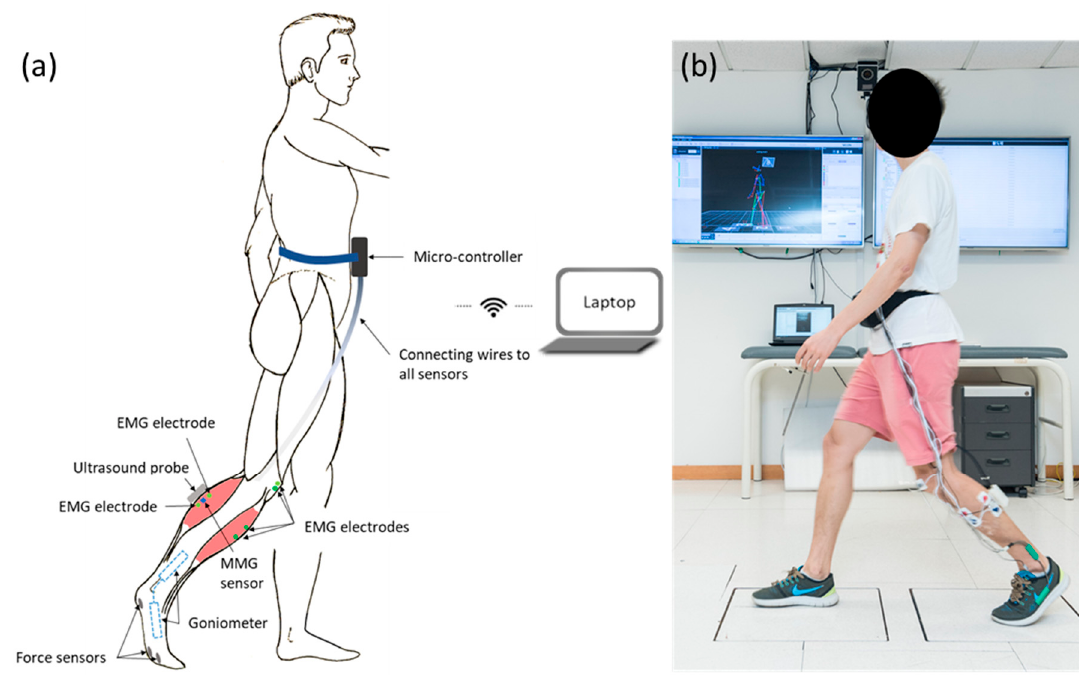
Figure 1. ( a ) An illustration of the wearable mobile sensing system with real-time ultrasound imaging and location of ultrasound probe, electromyography (EMG) electrode, mechanomyography (MMG) electrode, force sensors, and goniometer at shank and foot. ( b ) A demonstration of a subject wearing the wearable mobile sensing system.